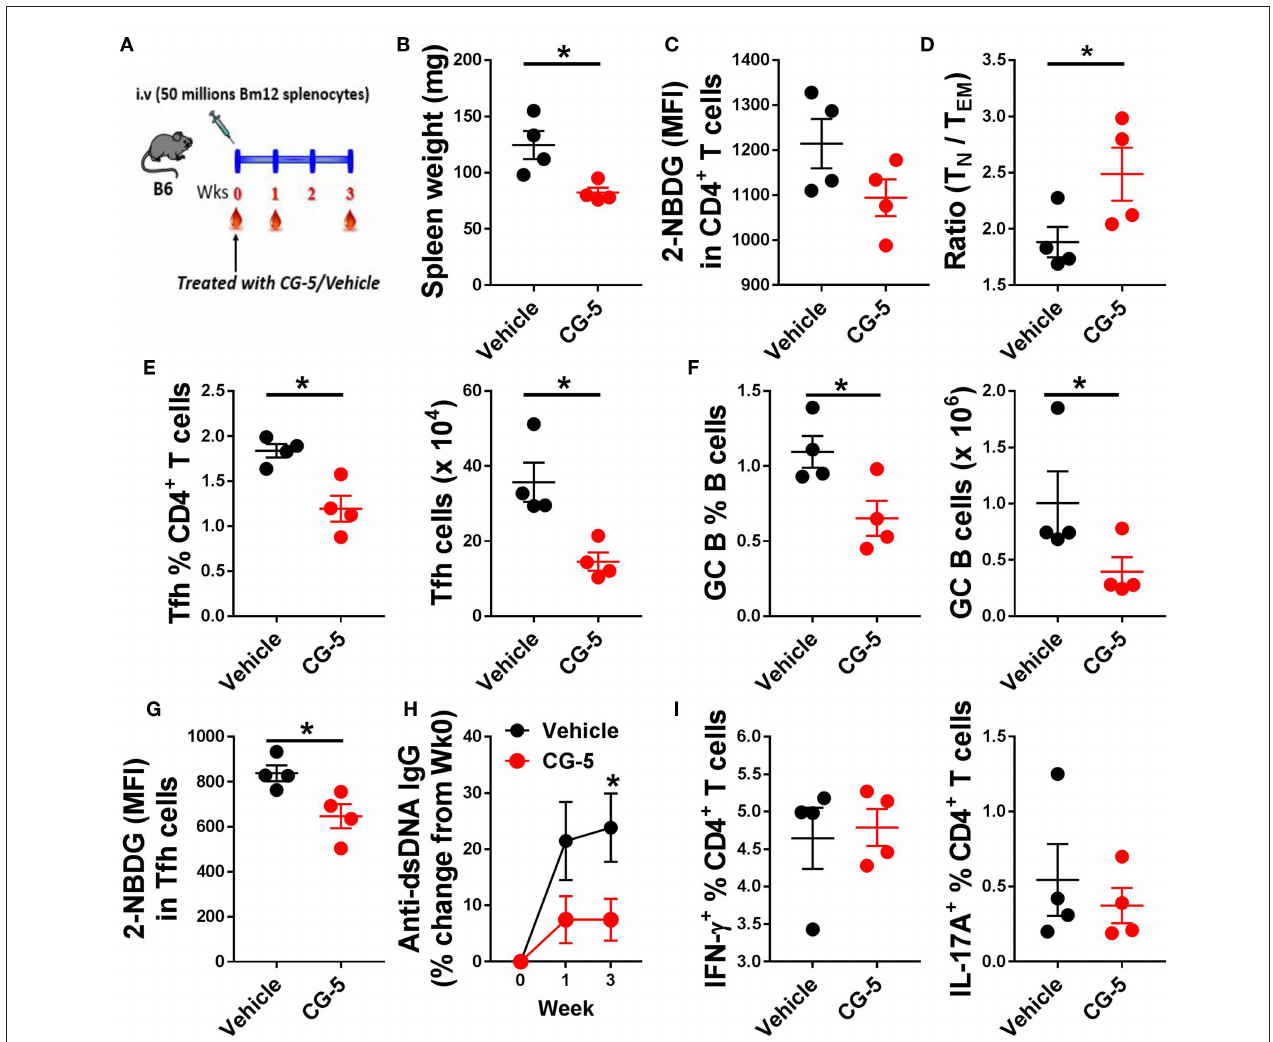
FIGURE 6 | CG-5 reduces cGVHD induced autoimmunity. Phenotypes were analyzed 3 weeks after cGVHD induction with bm12 splenocytes in B6 mice treated with vehicle or CG-5. (A) Experimental design. (B) Spleen weight. (C) Glucose uptake in CD4 + T cells measured as 2-NBDG MFI. (D) Ratio of naïve (T N )/effector memory (T EM ) CD4 + T cells. Frequency and number of Tfh cells (E) and GC B cells (F) . (G) 2-NBDG MFI in Tfh cells. (H) Serum anti-dsDNA IgG normalized to week 0. (I) Frequency of IFN- γ or IL-17A-positive CD4 + T cells in splenocytes from treated mice and controls. Mean ± S.E.M of n = 4 per group compared with t -tests. * p <